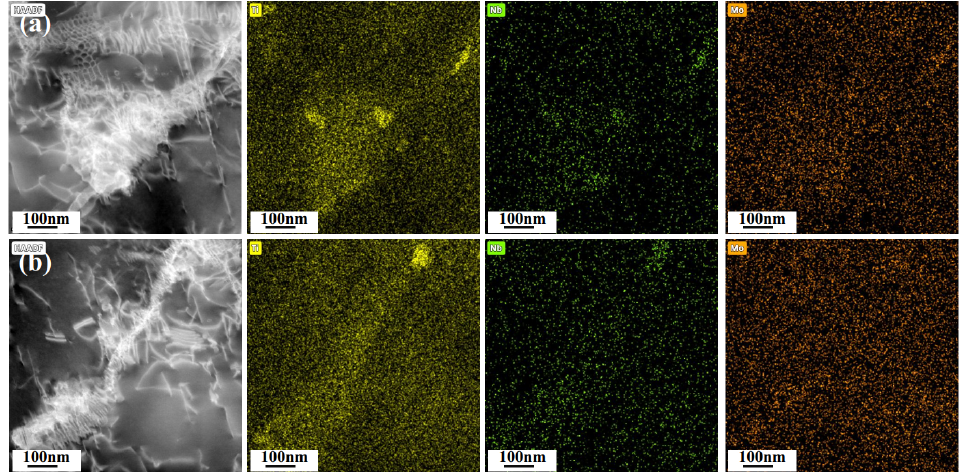
Figure 8. High-angle annular dark field (HAADF)-STEM images and EDS analysis of Laves phase at ( a ) bottom and ( b )